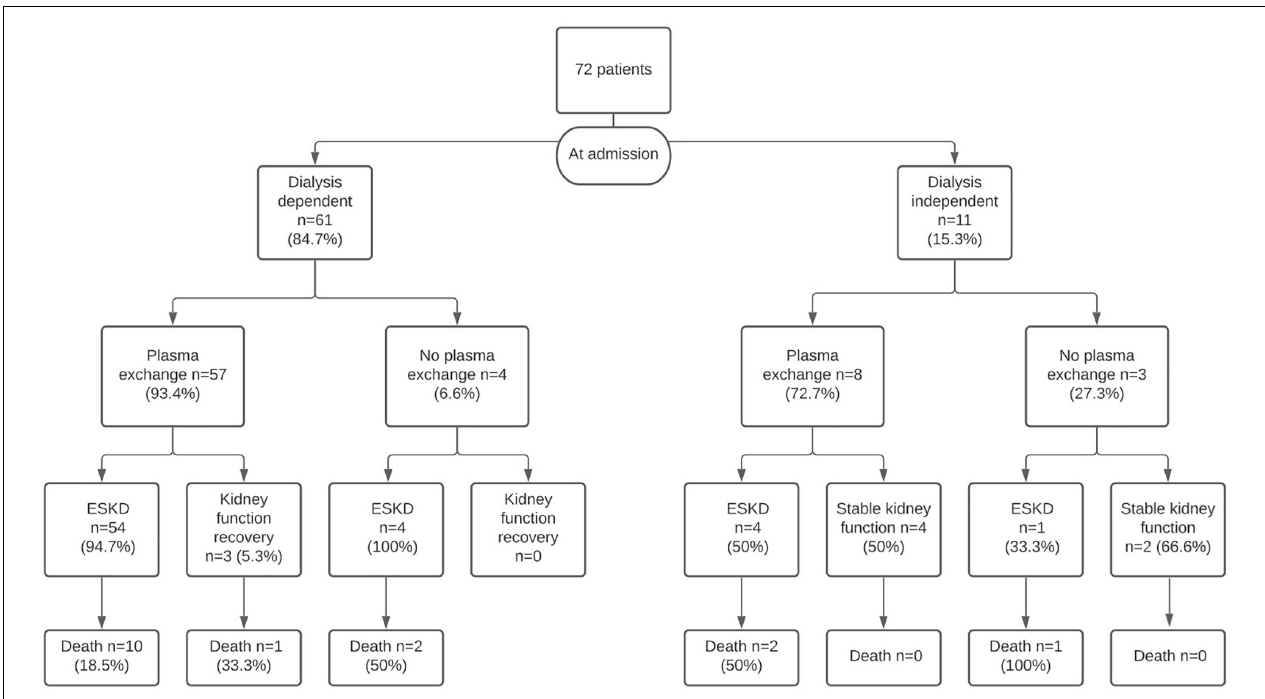
FIGURE 1 | The flowchart shows the patient’s outcomes according to the treatment received.